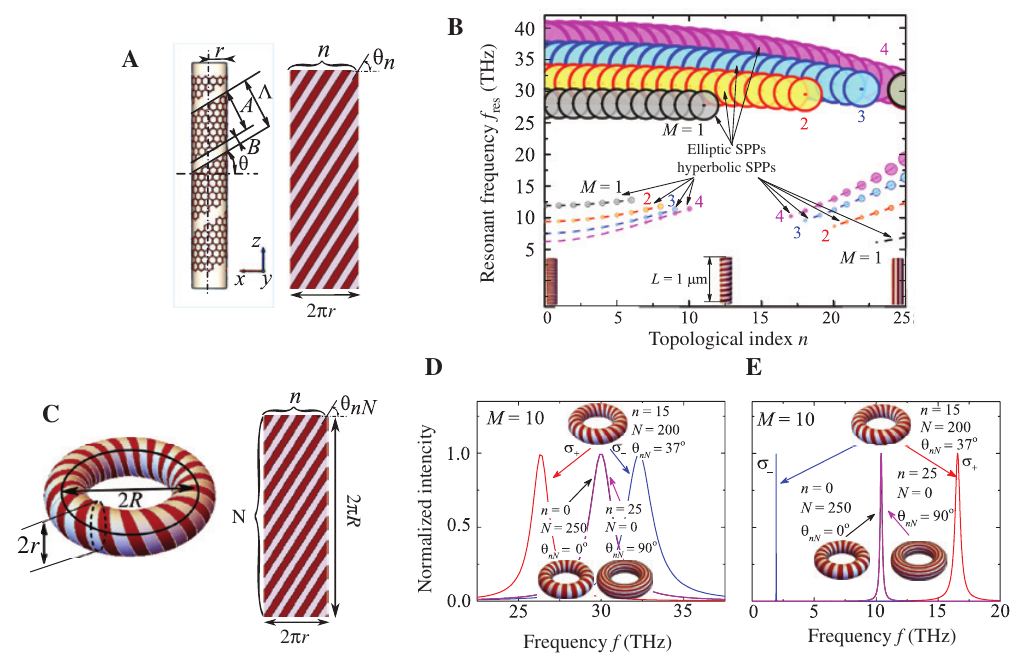
Figure 8: Topological transformations of nanostructures formed by meta-surfaces. A graphene-based meta-tube (A) is obtained by winding a bunch of n -identical graphene stripes around the cylindrical core under the fixed angle θ meta-tube (B) depend on the topological index n . A graphene-based meta-torus (C) is obtained by bending a meta-tube in a donut: it is char- acterized by a pair of topological indexes n and N . Elliptic (D) and hyperbolic (E) σ and different n and N ; these resonances display a large spitting for a chiral structure ( n = 15, N = 200) and are degenerate for the tori with perpendicular ( n = 0) and parallel ( N = 0) stripes (see text for details). Adapted from